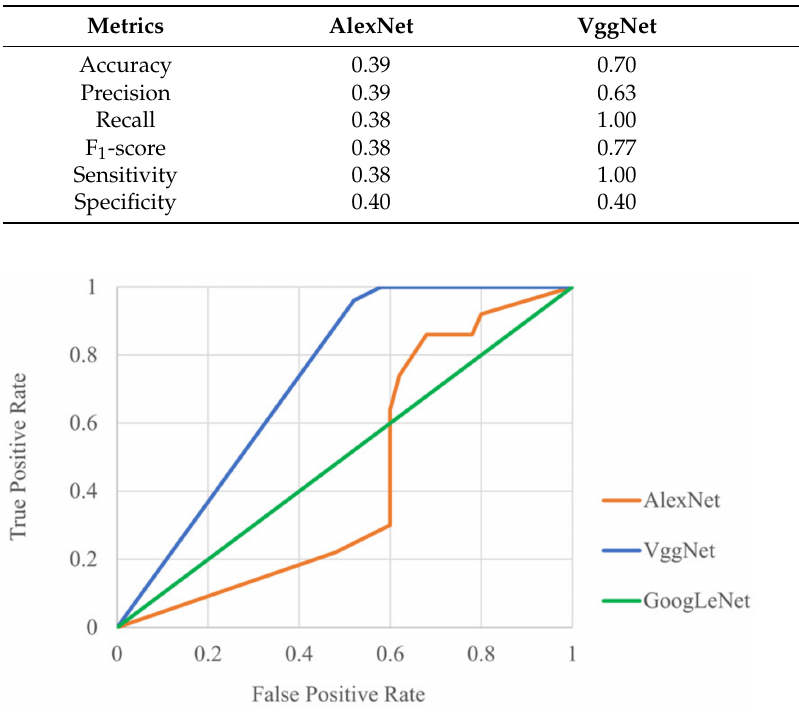
Figure 28. The ROC curve of three CNN models under different viewpoints. Table 5. AUC comparison under different